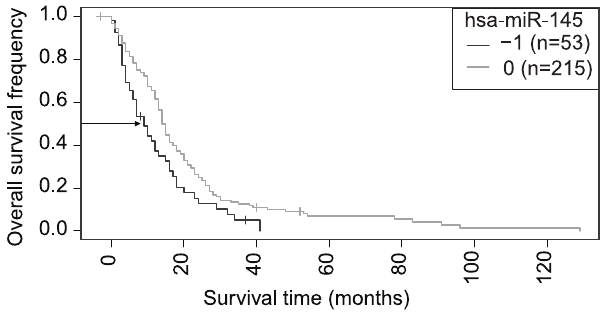
Figure 4. Kaplan-Meier analysis of the hsa-miR-145 miRNA in clinical TCGA GBM samples (n=268 in total). Significant survival difference with p , 0.005 is seen between the hsa-miR-145 low expression group (group denoted with 2 1, n=53) who have poor survival and the high or normal expression group (denoted with 0, n=215) with a threefold change threshold between patient groups.